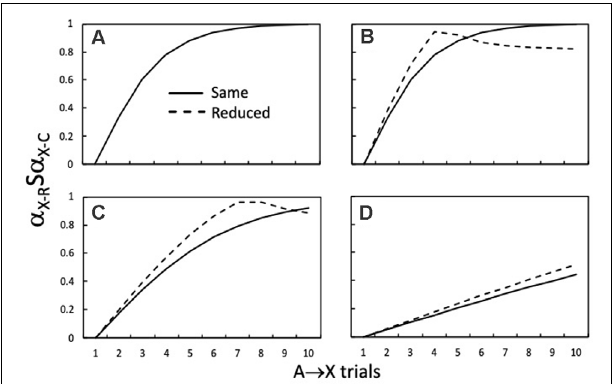
FIGURE 5 | How the similarity ( α X-R S α X-C ) of the retrieved X ( α X-R ) to the conditioned X ( α X-C ) during a test with A varies with the number of initial A → X trials. The continuous lines denote α X-R S α X-C output values when the α X value (0.50) used to compute changes in V A-X (i.e., α X-R ) was the same as that for α → US conditioning trials. α X-C on X A was 0.50 in panels (A,B) , 0.30 in panel (C) , and 0.10 in panel (D) . The dashed lines denote α X-R S α X-C output values when the α X value used to compute changes in V A-X (0.50; i.e., α X-R ) was reduced to 0.45 for α X-C to calculate α X-R S α X-C. This manipulation is akin to using trace conditioning for X → US trials. Adapted from Honey and Dwyer (under